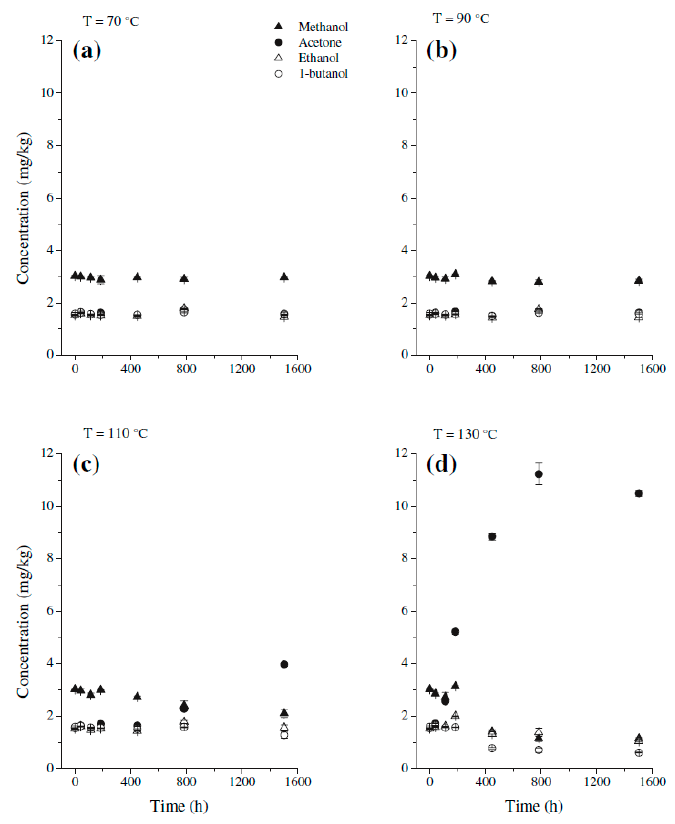
Figure 7. Stability with time of methanol and other compounds at different temperatures ( a ) 70 °C, ◦ C, ( c ) 110 ◦ C, ( d ) 130 ◦ C, from ( b ) 90 °C, ( c ) 110 °C, ( d ) 130 °C, from [1]. 90